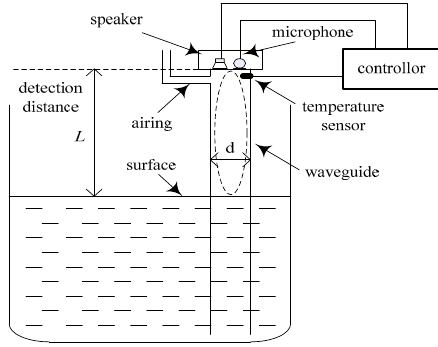
Figure 5. Structure of a level gauge.